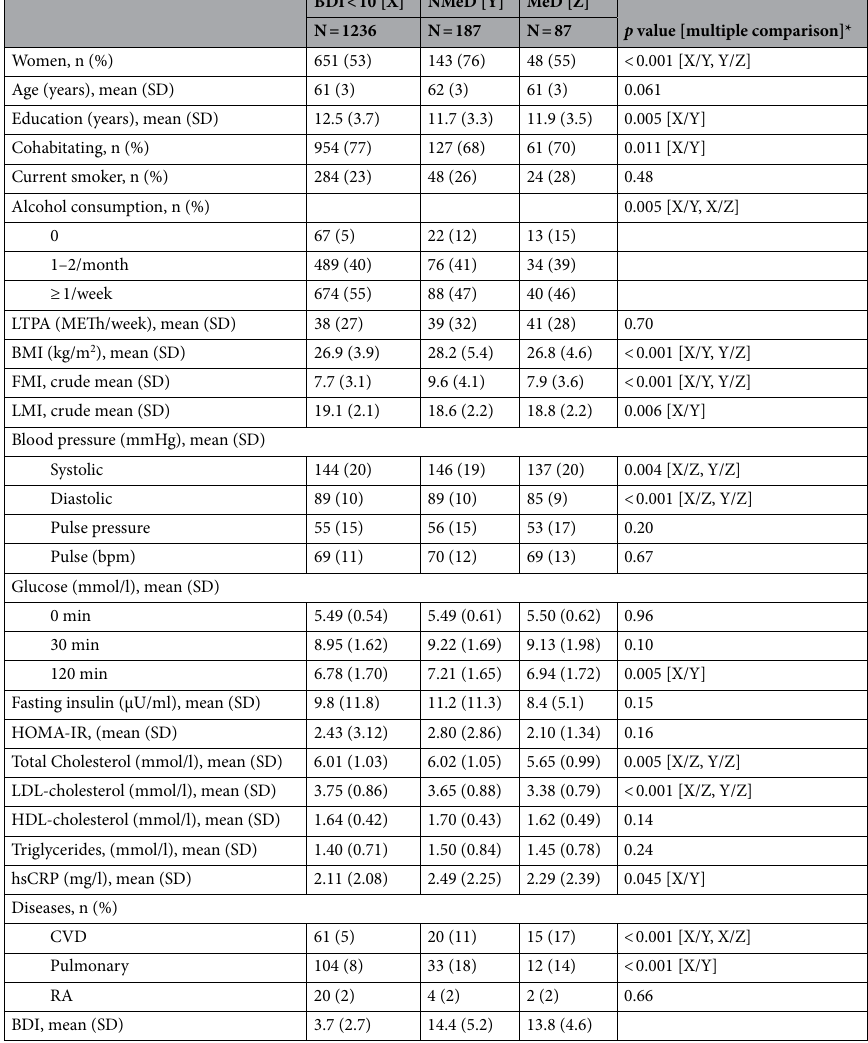
Table 2. Characteristics according to depressive subtypes. Disease subgroups: CVD : angina pectoris, myocardial infarction, stroke; Pulmonary : asthma, chronic obstructive pulmonary disease. BDI